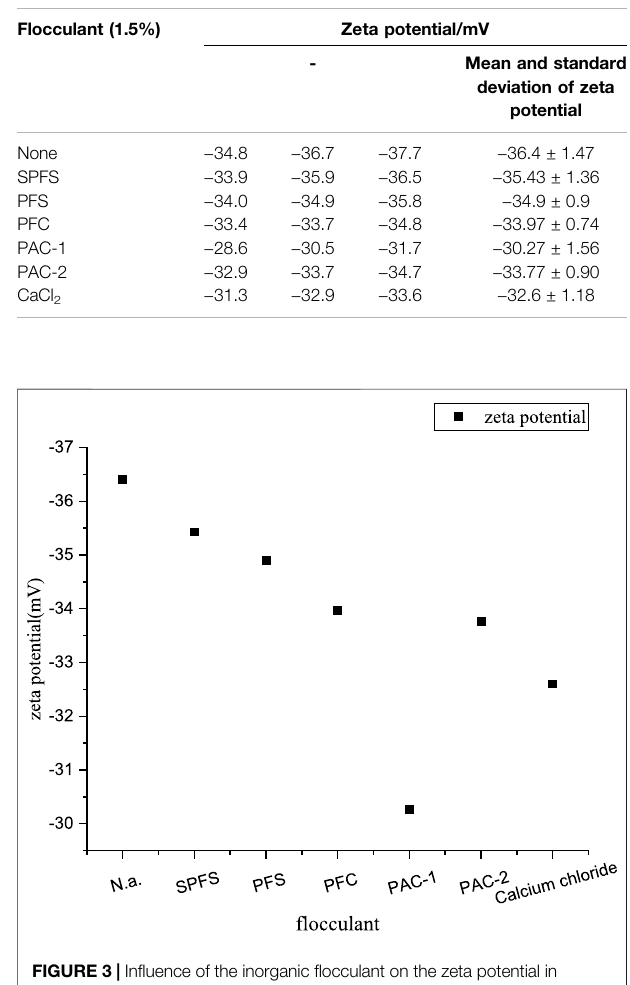
FIGURE 3 | In fl uence of the inorganic fl occulant on the zeta potential in Biodrill-A drilling fl